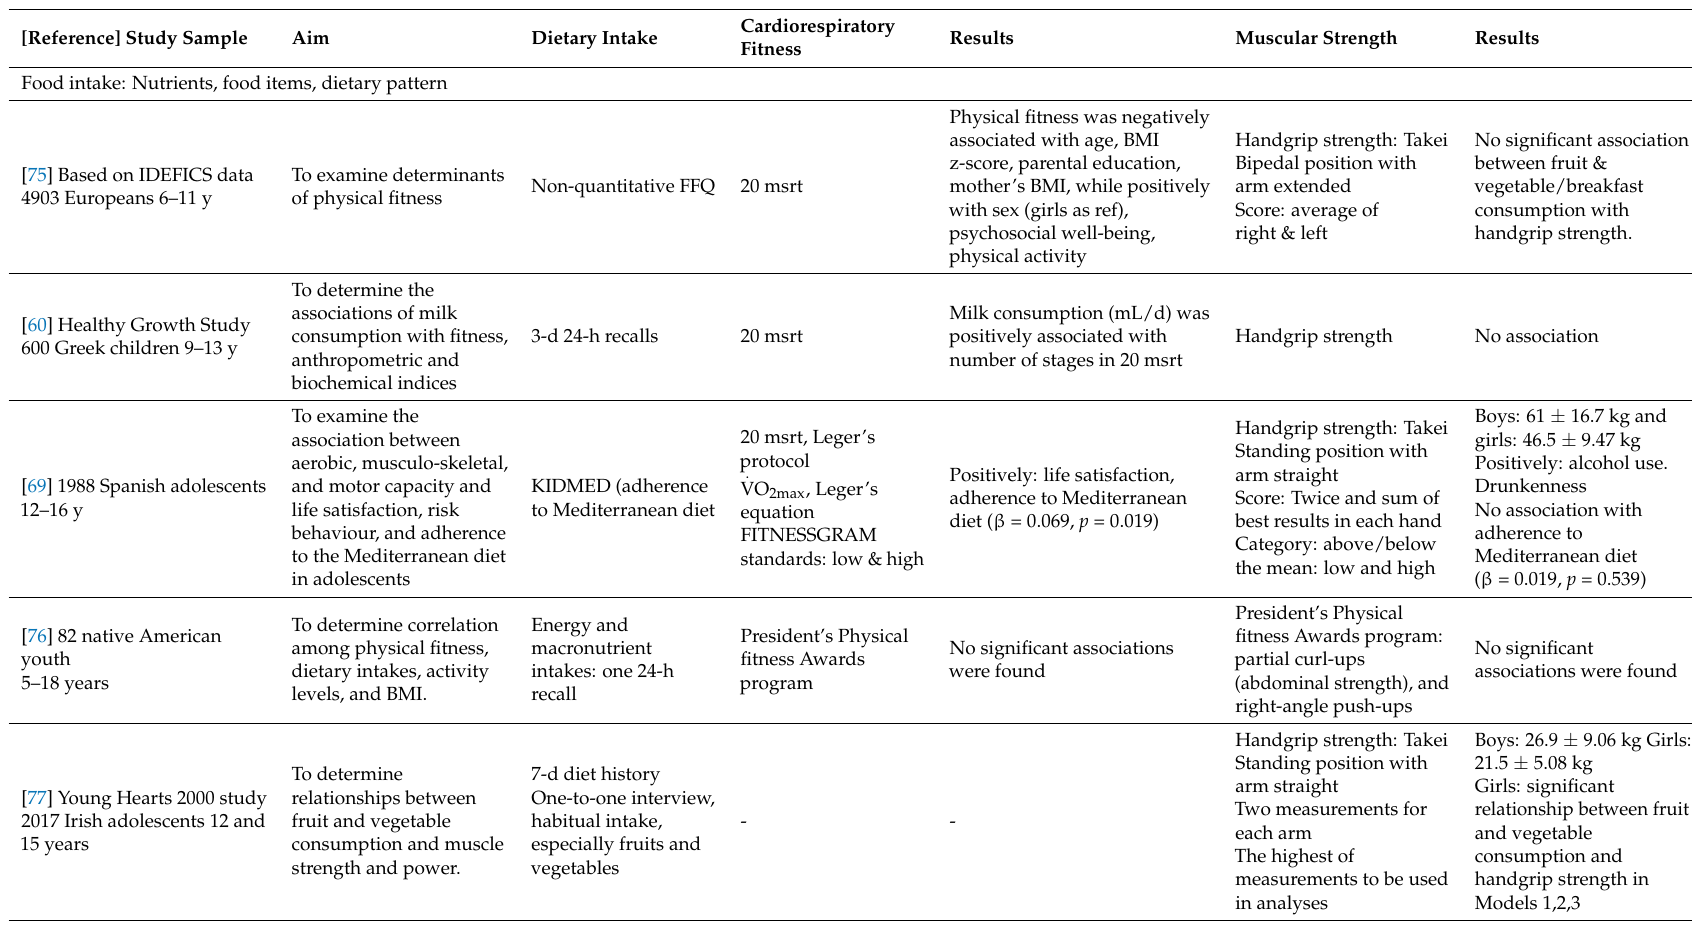
Table 2. Dietary intake and measures of physical